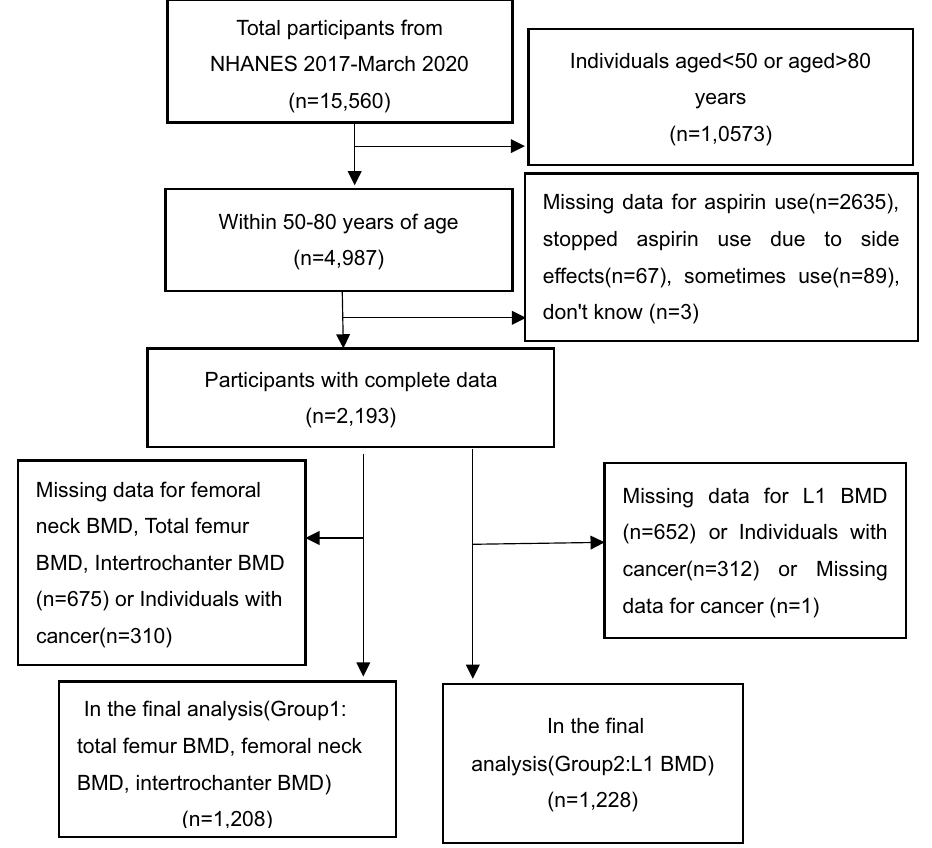
Figure 1. Flow chart of NHANES sample selection from March 2017 to March